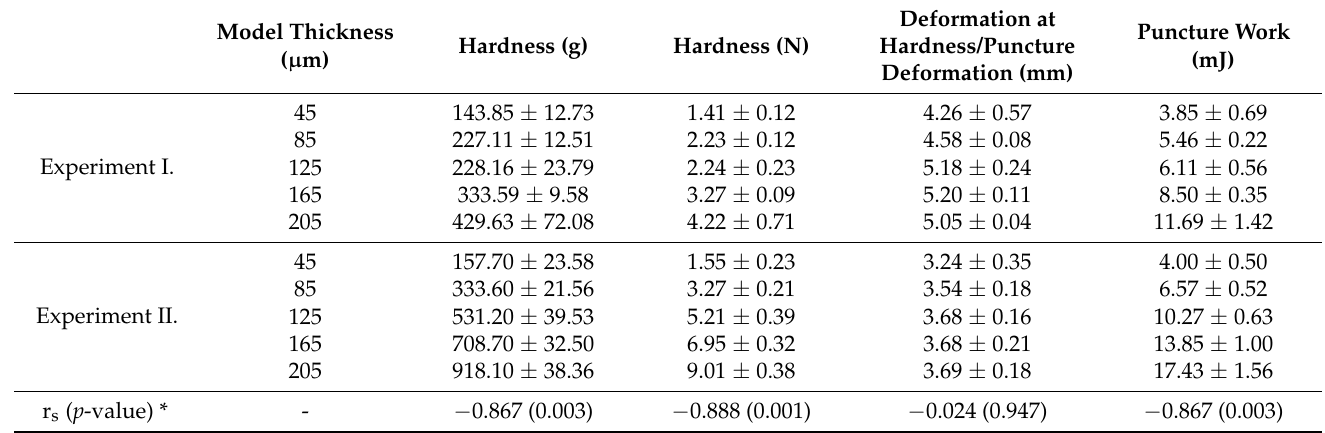
Table 5. Summary of results from puncture